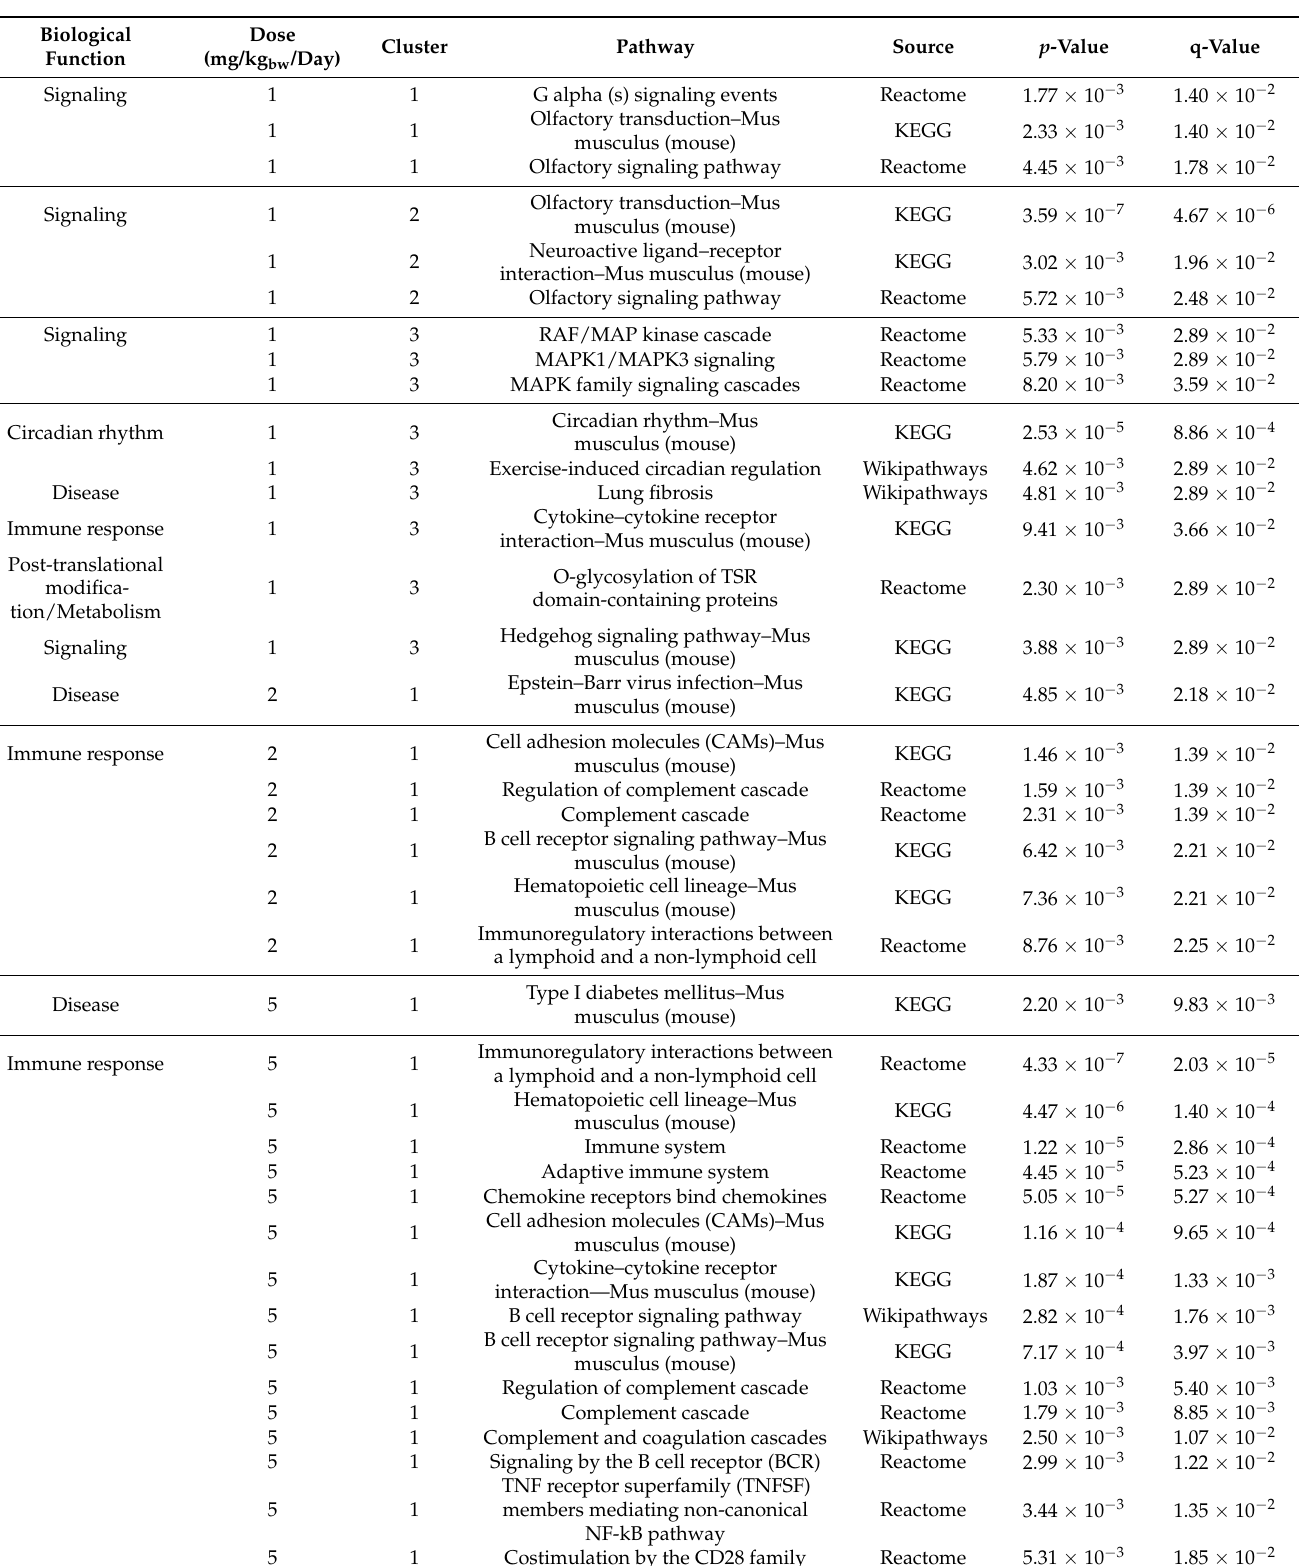
Table 4. Pathways over-representation analysis (ORA) resulting from STEM analysis of the gene expression changes from all genes following the exposure to 1, 2, and 5 mg/kg bw /day of E171 over time. Profile colors indicate gene expression profiles that were assigned to a similar biological